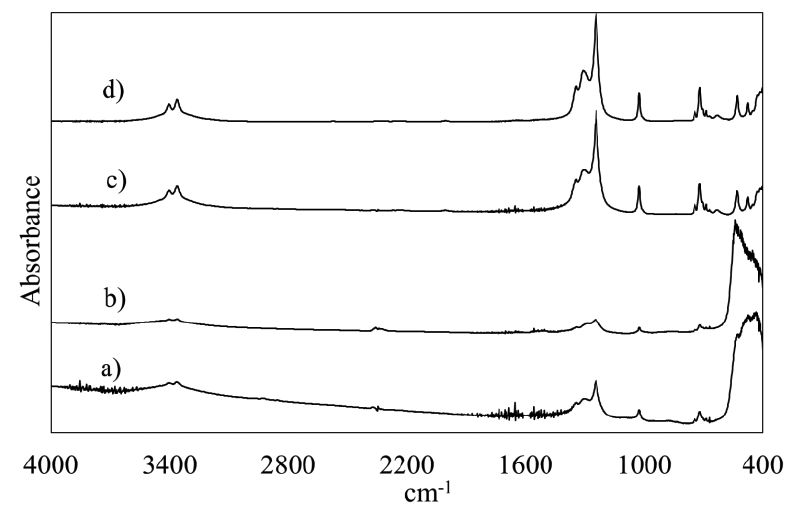
Figure 1: FTIR spectra of solid products synthesized at different temperatures: a) 90°C, b) 100°C, c) 110°C, and d)